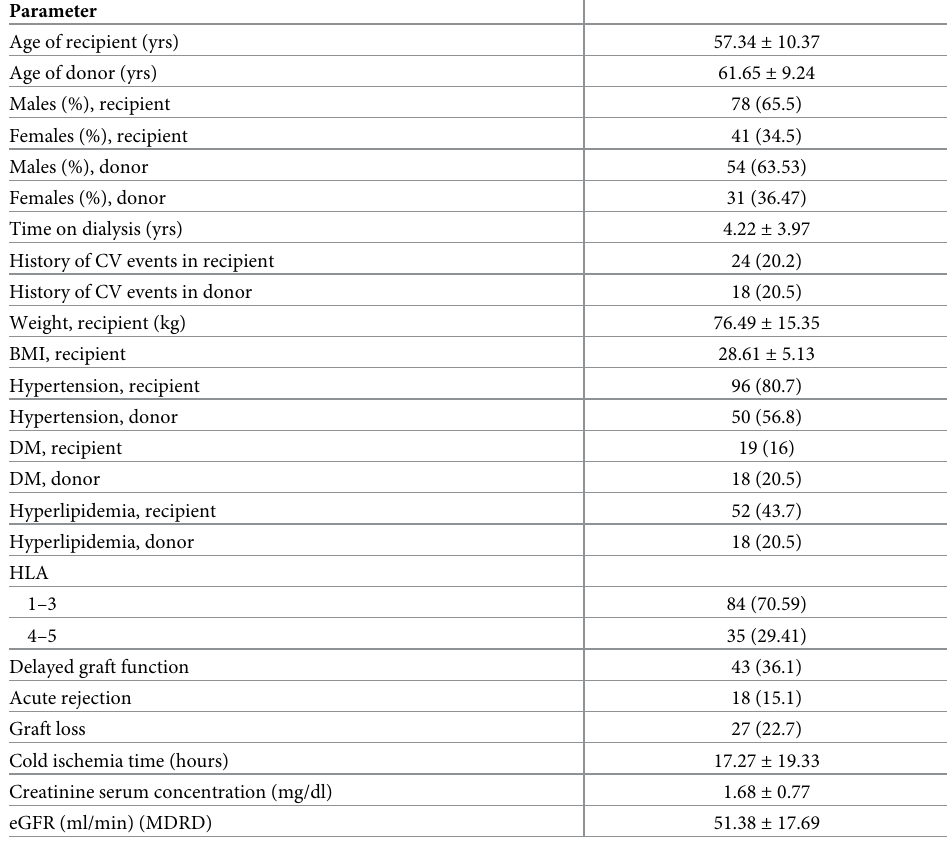
Table 1. Clinical and demographic parameters of the study population. Mean ± standard deviation values or num- ber and percentages are